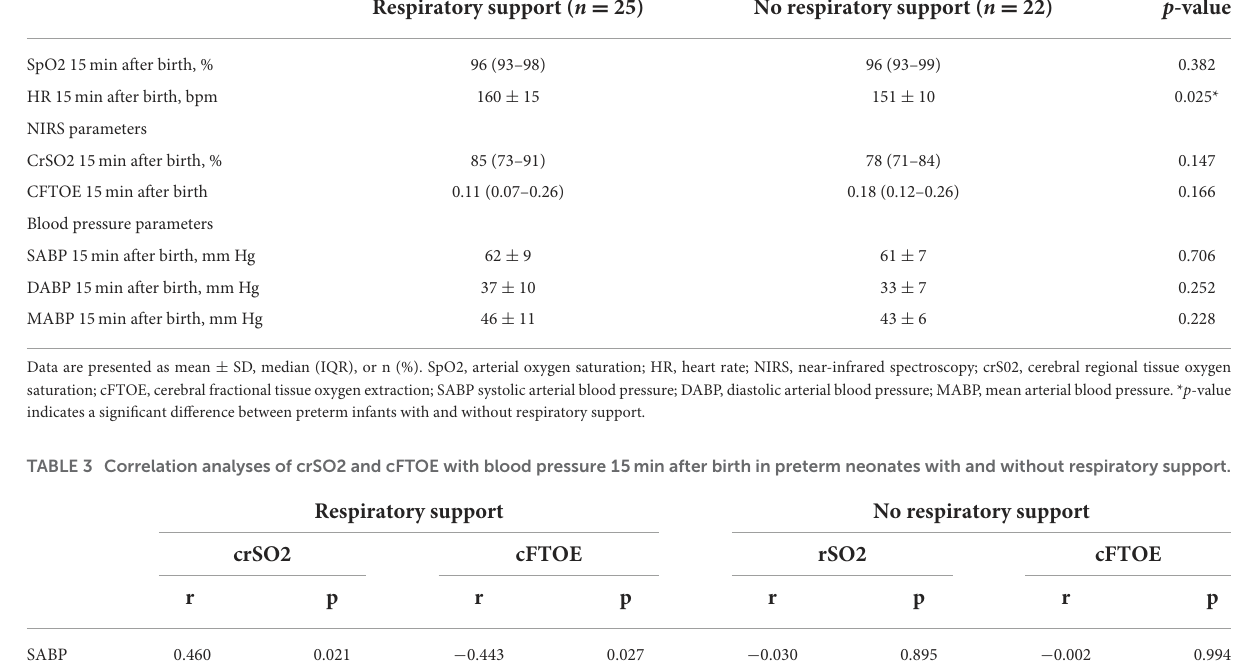
TABLE 2 Routine parameters, NIRS parameters and blood pressure parameters of preterm neonates with and without respiratory support. Respiratory support ( n = 25)